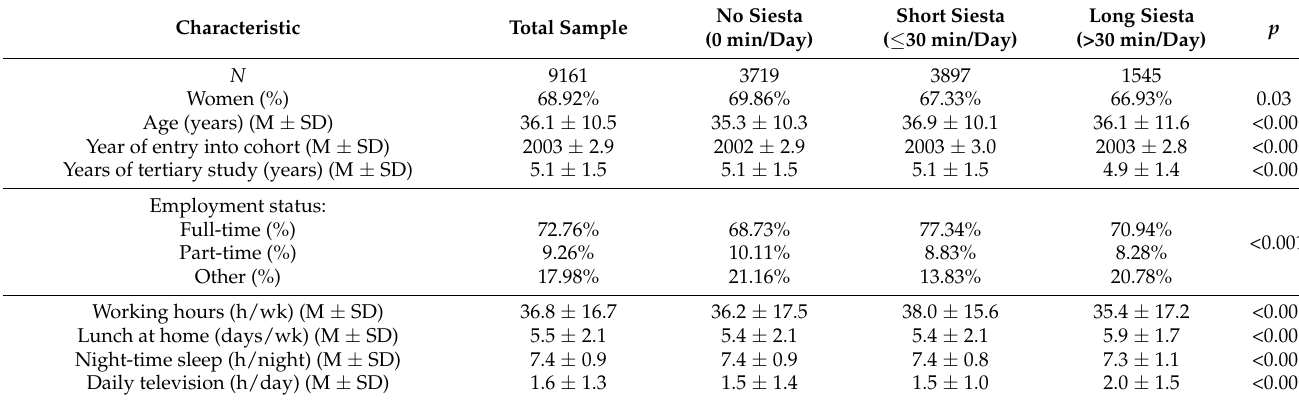
Table 1. Baseline characteristics of sample